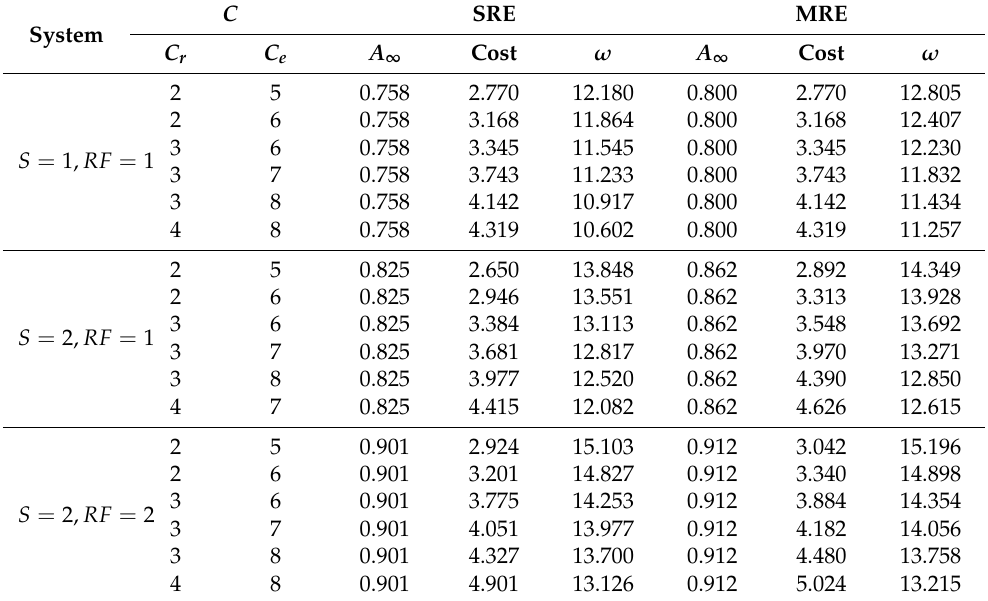
Table 2. Cost–profit analysis under different cost parameters C r and C e , when R p − C p = 20, C l =